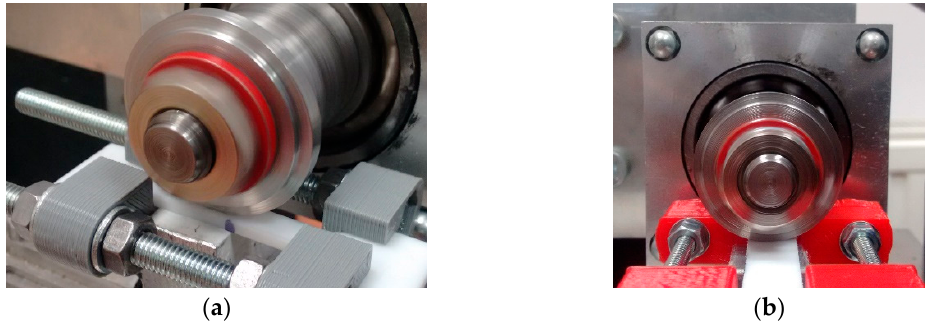
Figure 5. The combination of stretched polymer – steel roller when measuring wear in a direction: ( a ) parallel and ( b ) perpendicular to the direction of the tensile force vector.